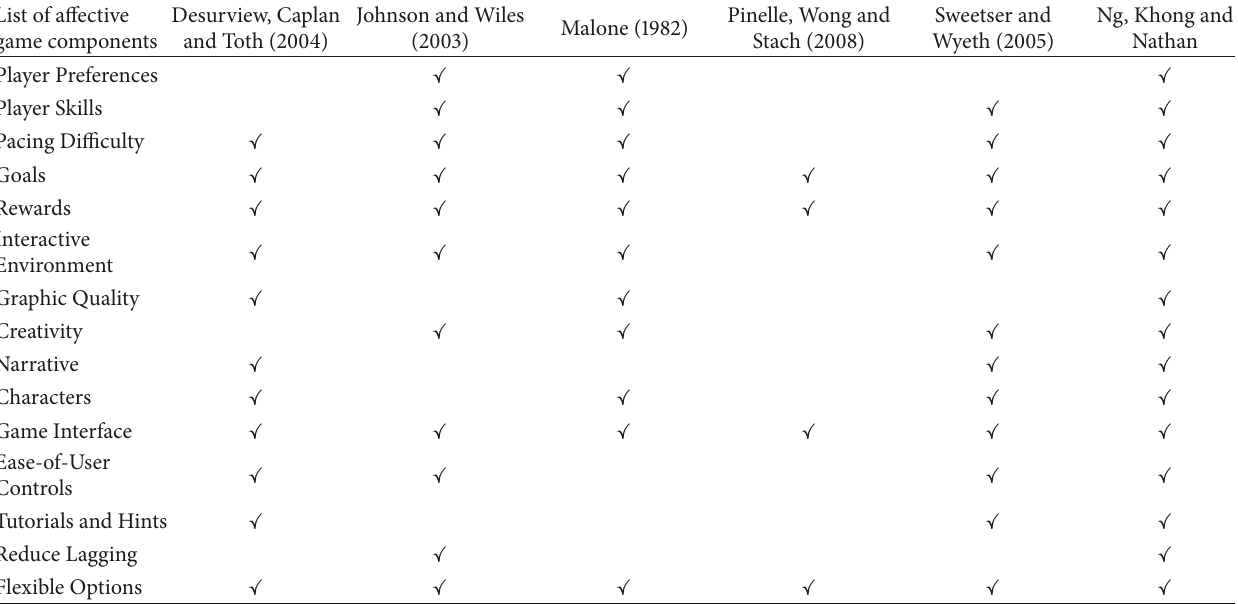
Table 4: Mapping with other researchers’